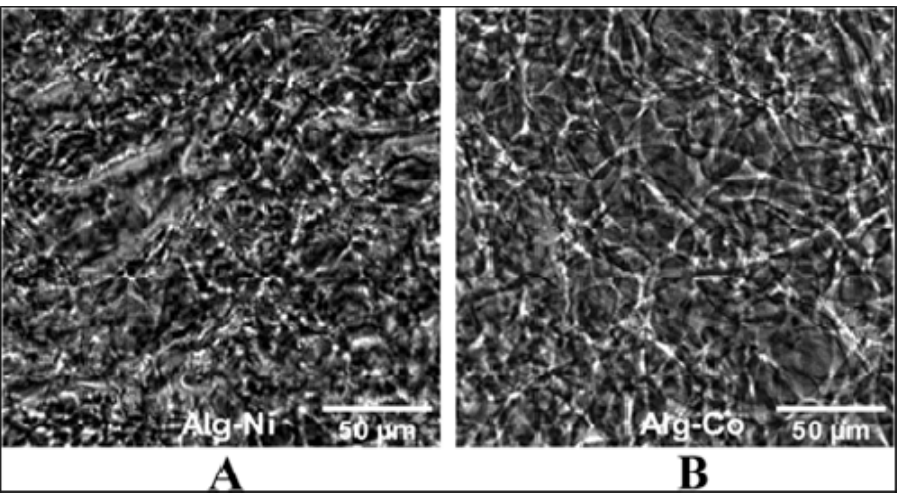
Figure 1. Phase contrast images of nickel (II) alginate ( A ) and cobalt (II) alginate ( B ) -dried hydrogels. Scale bar represents 50 µm.